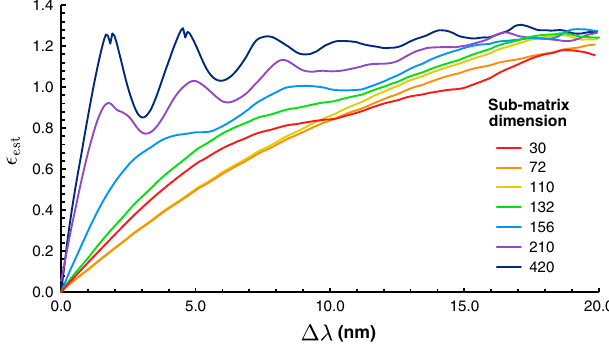
) is plotted as est